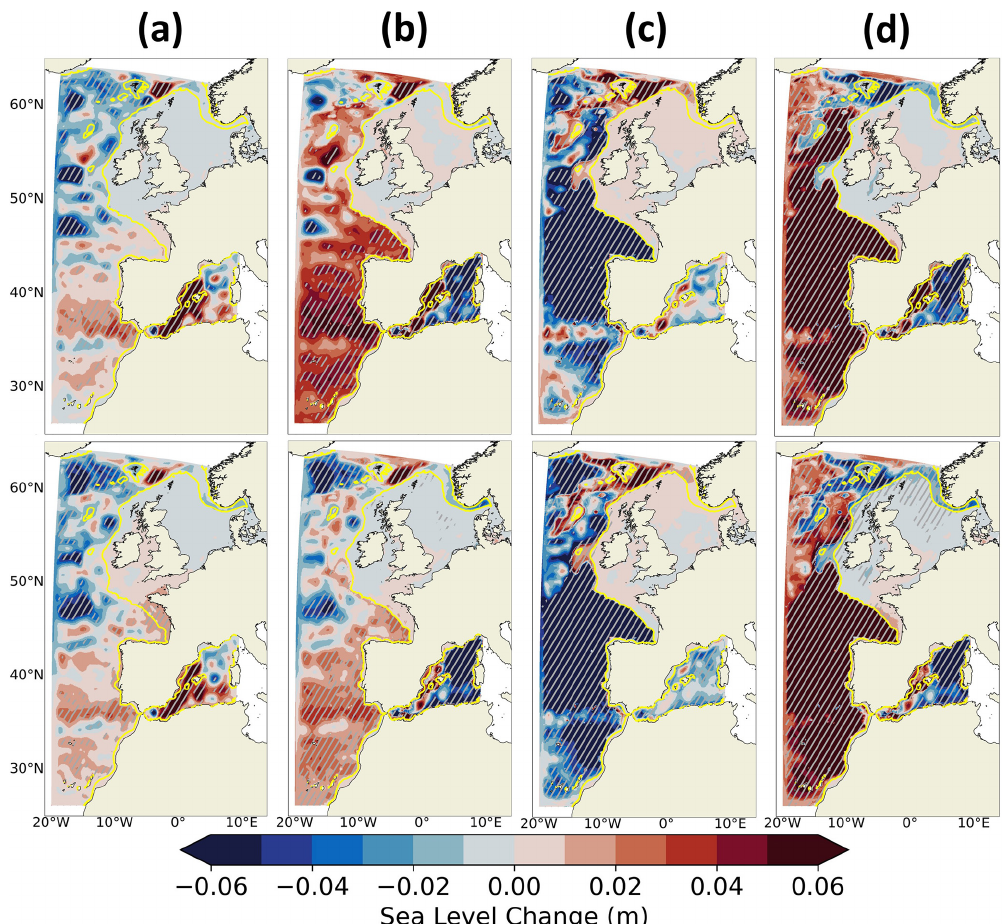
Figure 15. Differences of projected changes (2081–2100 vs. 1986–2005) between IBI-CCS_corr and IBI-CCS_raw simulations for the DSL (first column), the steric (second column), thermosteric (third column) and halosteric (last column) SL components under the SSP5-8.5 (upper row) and SSP1-2.6 (lower row) scenarios. The steric, thermosteric and halosteric SL components have been computed between 0–2000m depth. A Student t test has been performed with a confidence interval of 95%, and the significant differences between the two simulations have been marked with white dots. The shelf break (defined by the 200m isobath) is indicated in